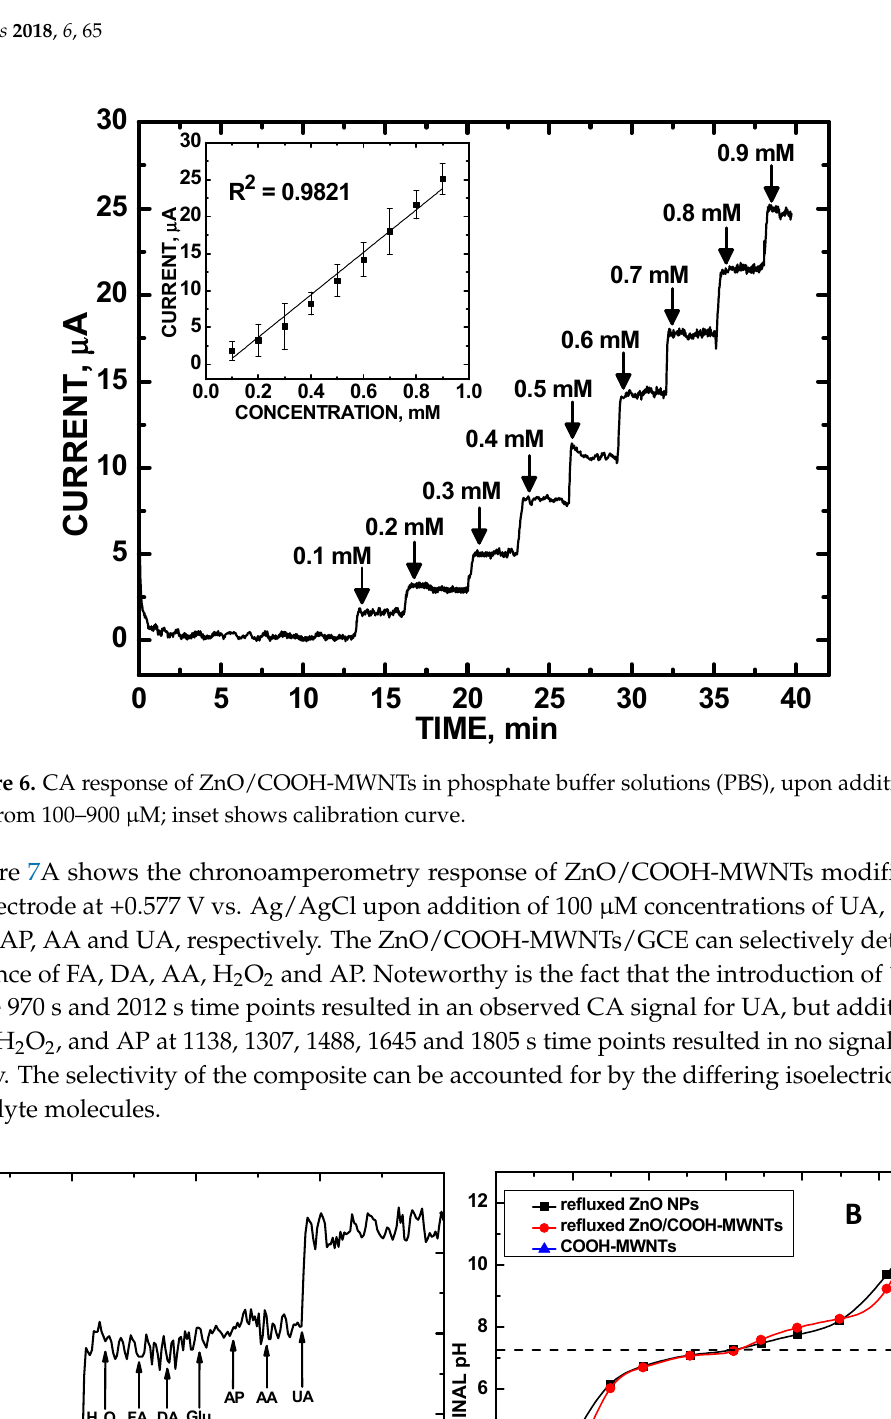
Figure 7. ( A ) CA response of the Nafion/ZnO/COOH-MWNTs/GCE at 0.577 V vs. Ag/AgCl electrode upon 100 μ M additions of UA, FA, AA, DA, H 2 O 2 , AP and UA, respectively; ( B ) point-of-zero (PZC) values of refluxed ZnO NPs (- ■ -), refluxed ZnO/COOH-MWNTs (- ● -) and COOH-MWNTs (- ▲ -).